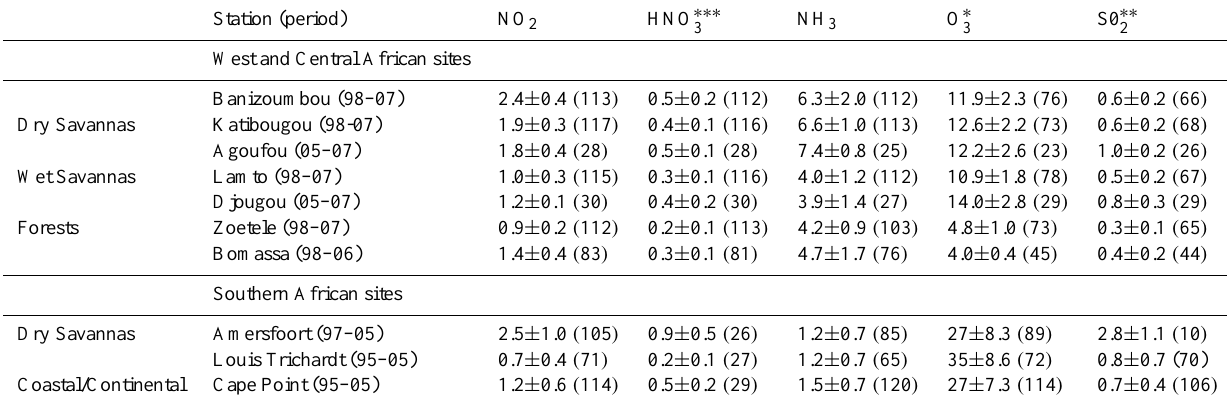
Table 5. Mean annual concentrations (in ppb) at IDAF sites and the number of acceptable duplicates (in brackets) . Station